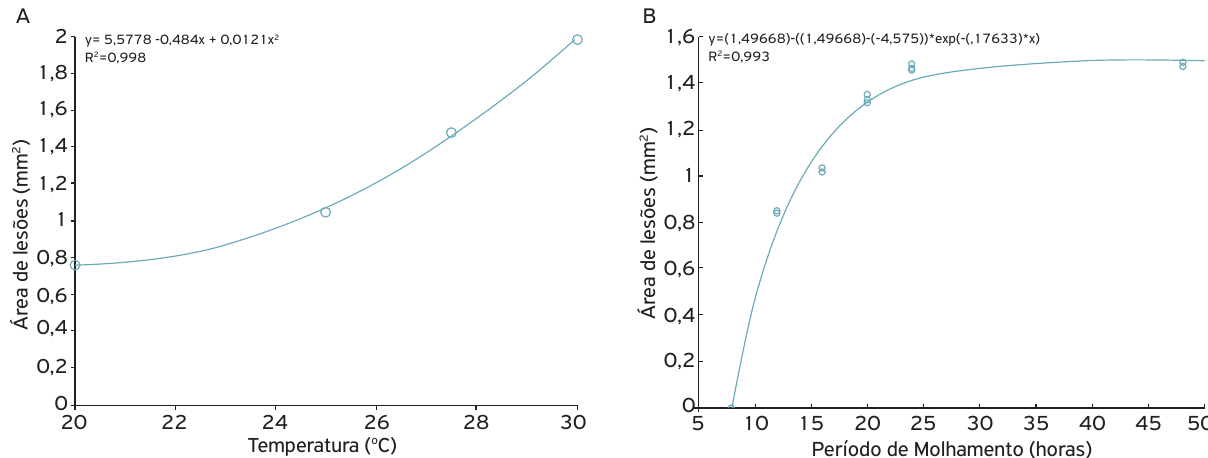
Figura 2. (A) Área (mm 2 ) das lesões de mancha-alvo, causada por Corynespora cassiicola, em folhas de Malpighia emarginata, mantidas sob 48 horas de câmara úmida e diferentes temperatura e (B) sob temperatura de 27,5 o C e diferentes períodos